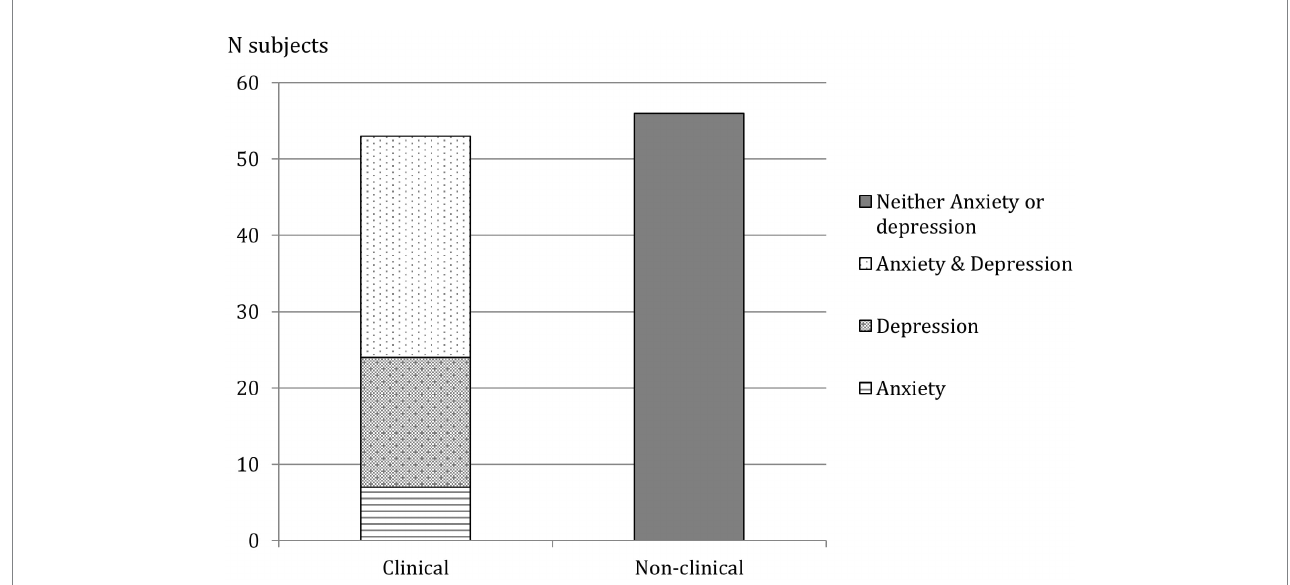
FIGURE 1 Clinical and non-clinical subjects according to HADS. Prevalence of anxiety and depression and both anxiety and depression are